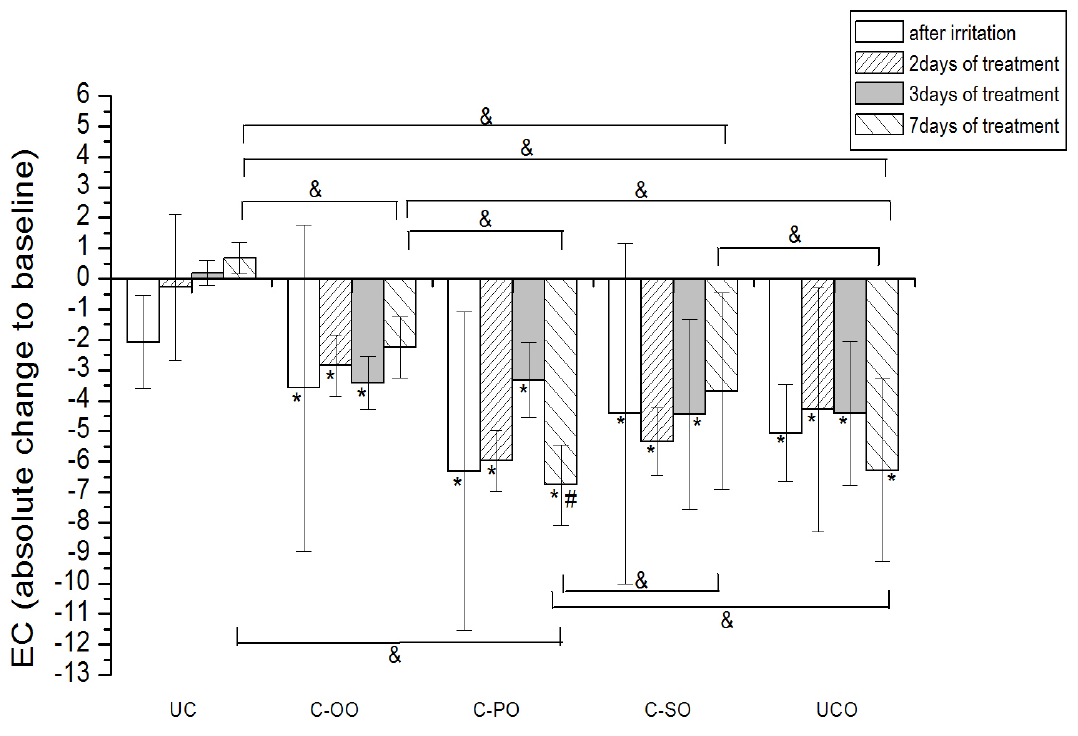
Figure 2. The influence of the irritation per se and samples C-OO, C-PO and C-SO after irritation on EC. Parameters were expressed as absolute changes to baseline at distinct time points. The effects of different formulations were compared mutually and to UC and UCO (significant differences being marked with &). Differences to corresponding sample with SJW (C-OO-E, C-PO-E and C-SO-E) were checked only on day 7, significant differences being marked with (#). (*) is for significant difference of EC at distinct time point related to baseline (means were